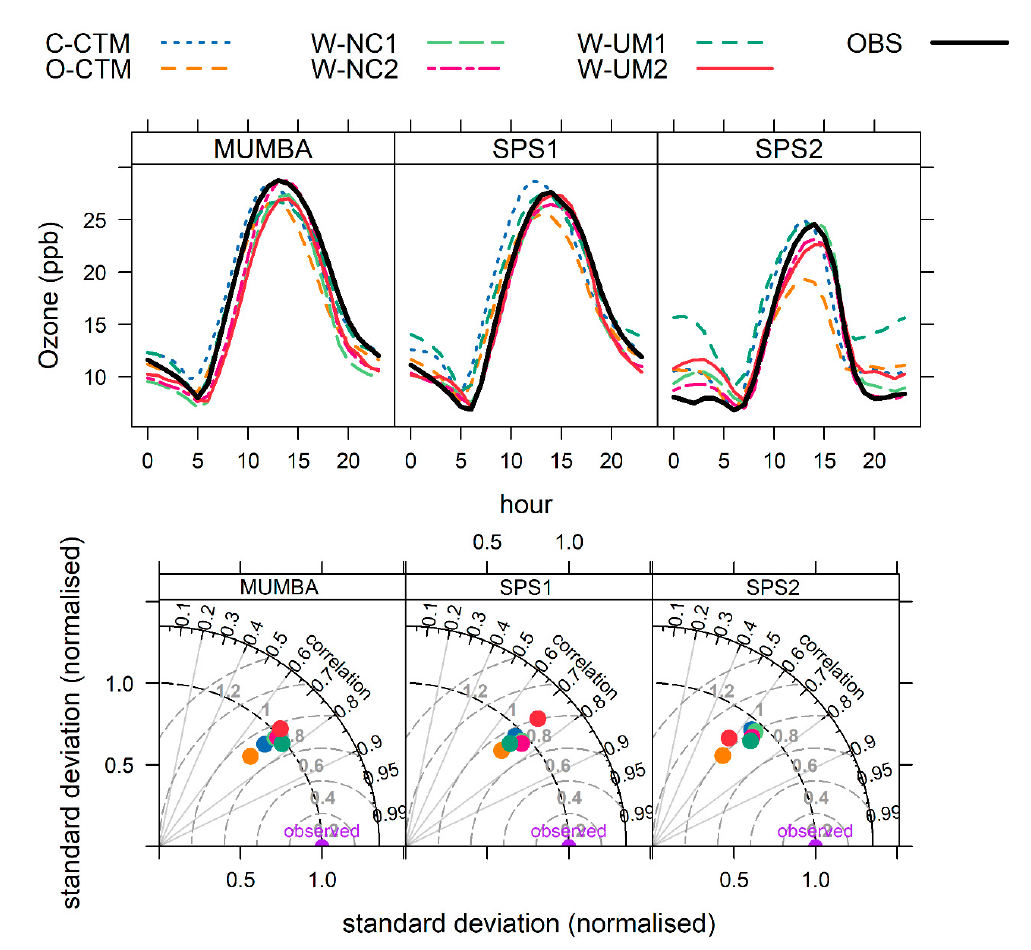
Figure 2. Composite diurnal cycles for observed and modelled O 3 during each campaign (upper panel) and Taylor diagrams for each campaign period (lower panel).